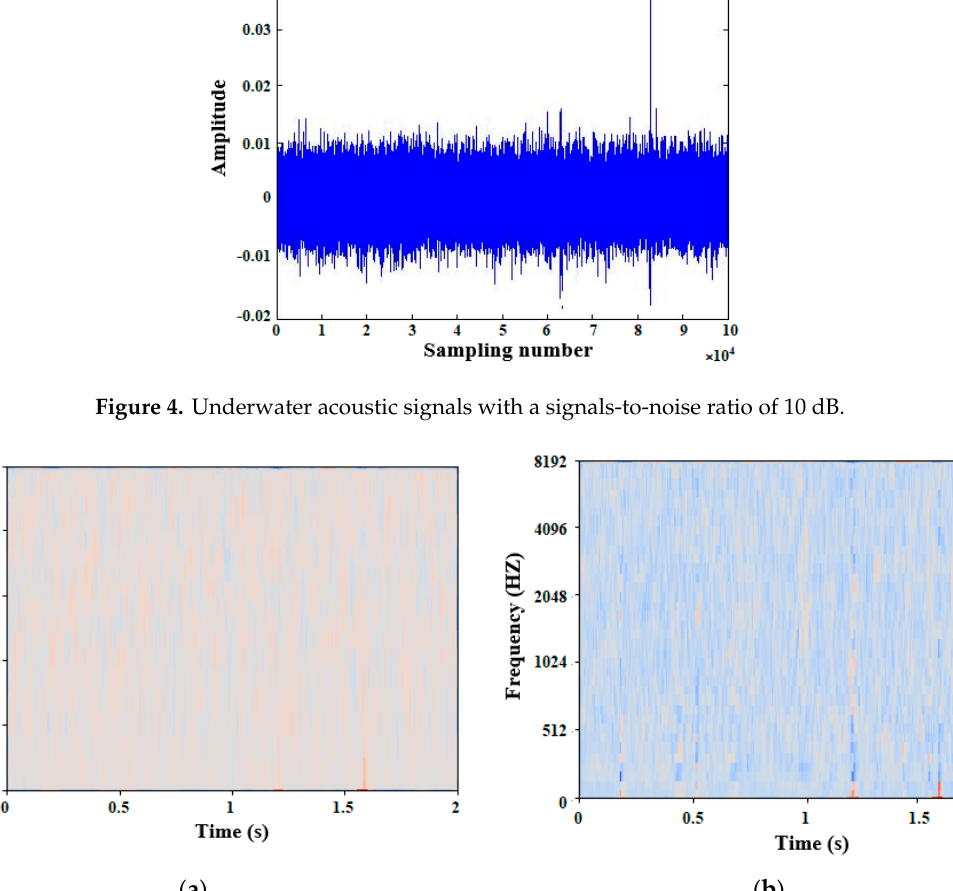
Table 1. The estimated optimal threshold and η of 20 different underwater sonar images. Experiment Times